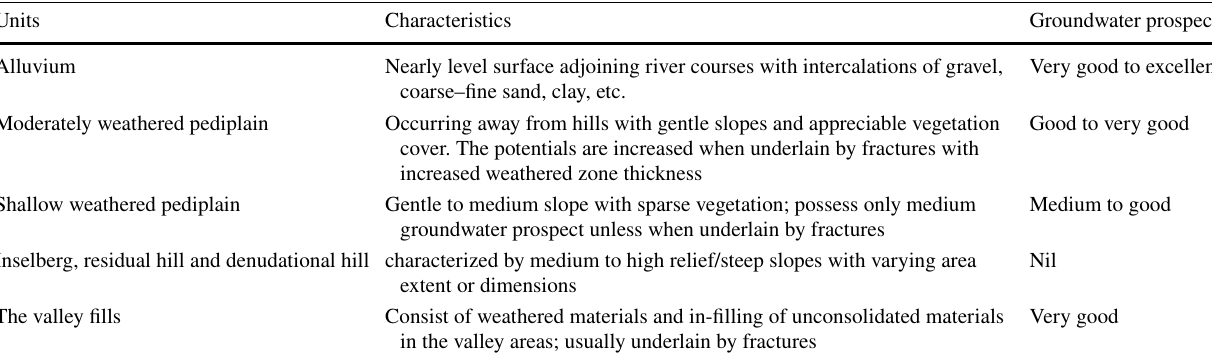
Table 1 Hydrogeomorphological characteristics in Ado-Ekiti (Rao and Jugran 2003; Talabi and Tijani